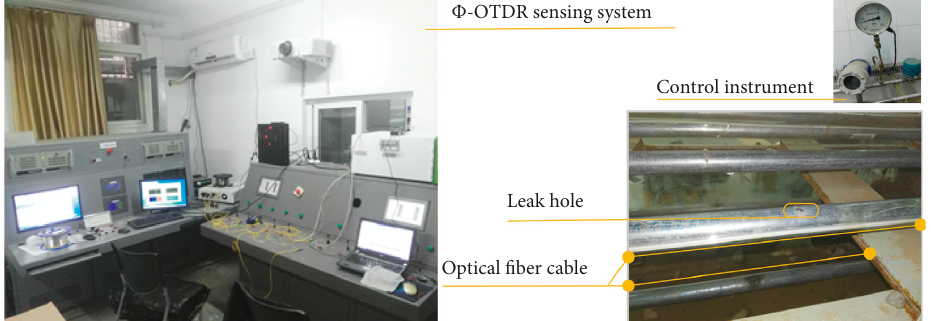
Figure 4: Experimental environment.